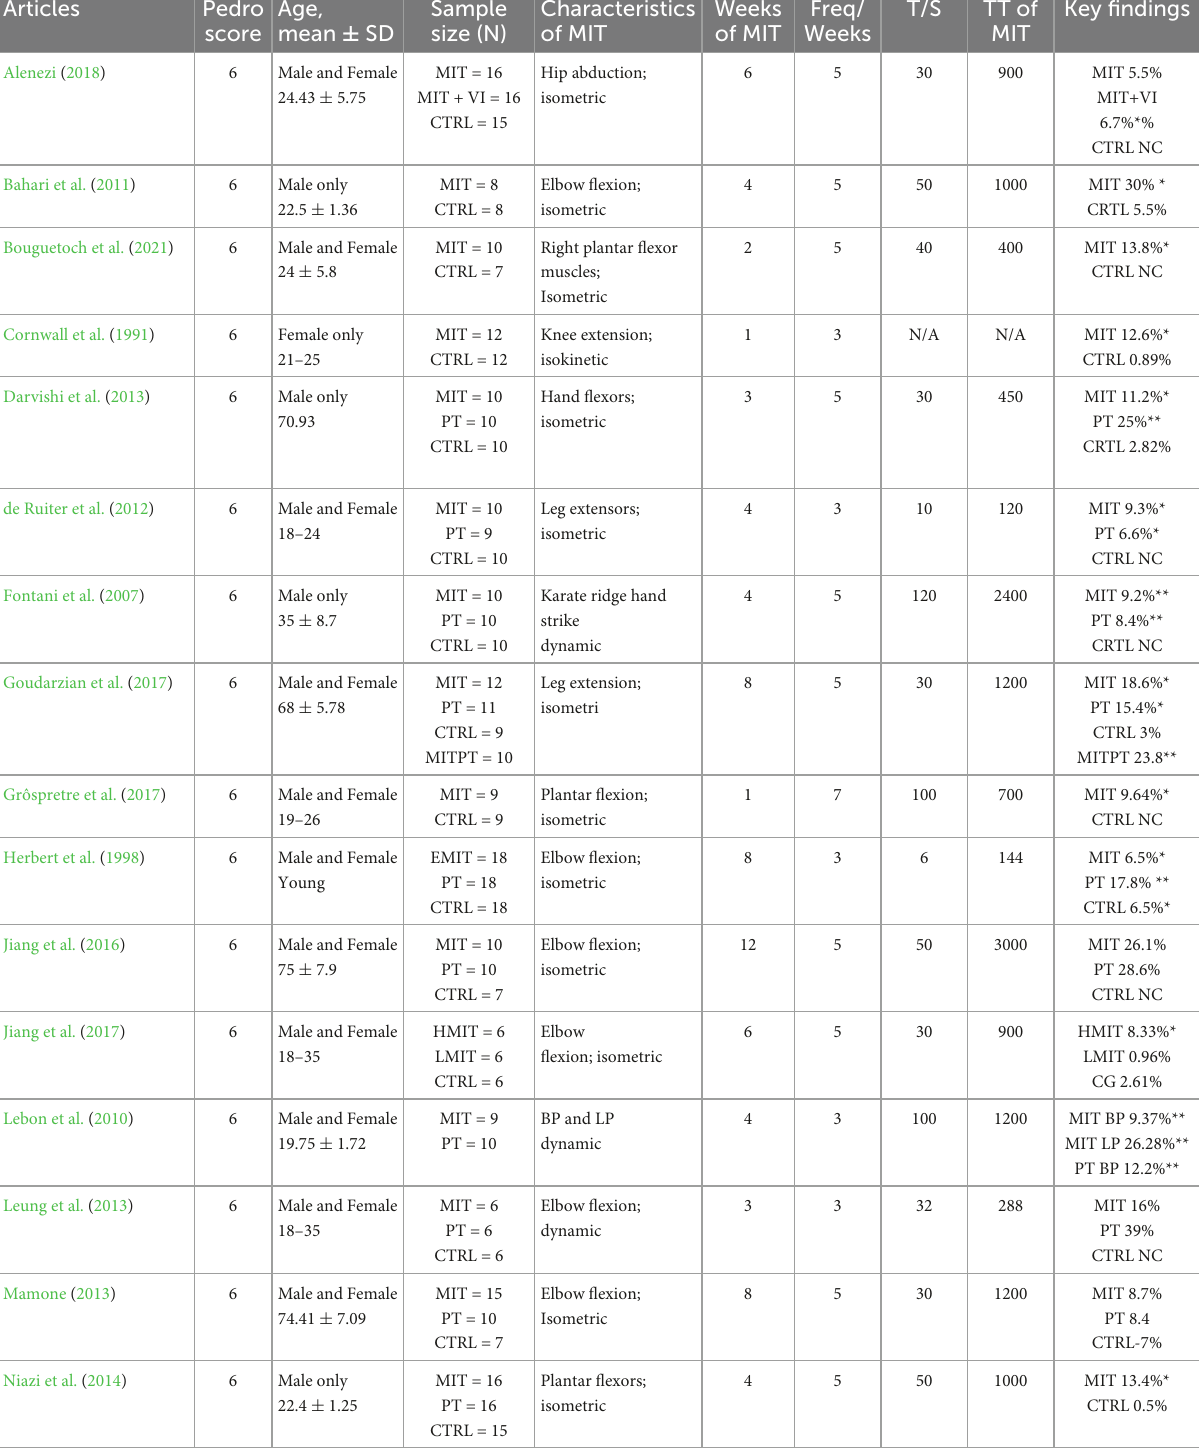
TABLE 1 Characteristics and major outcomes of the included